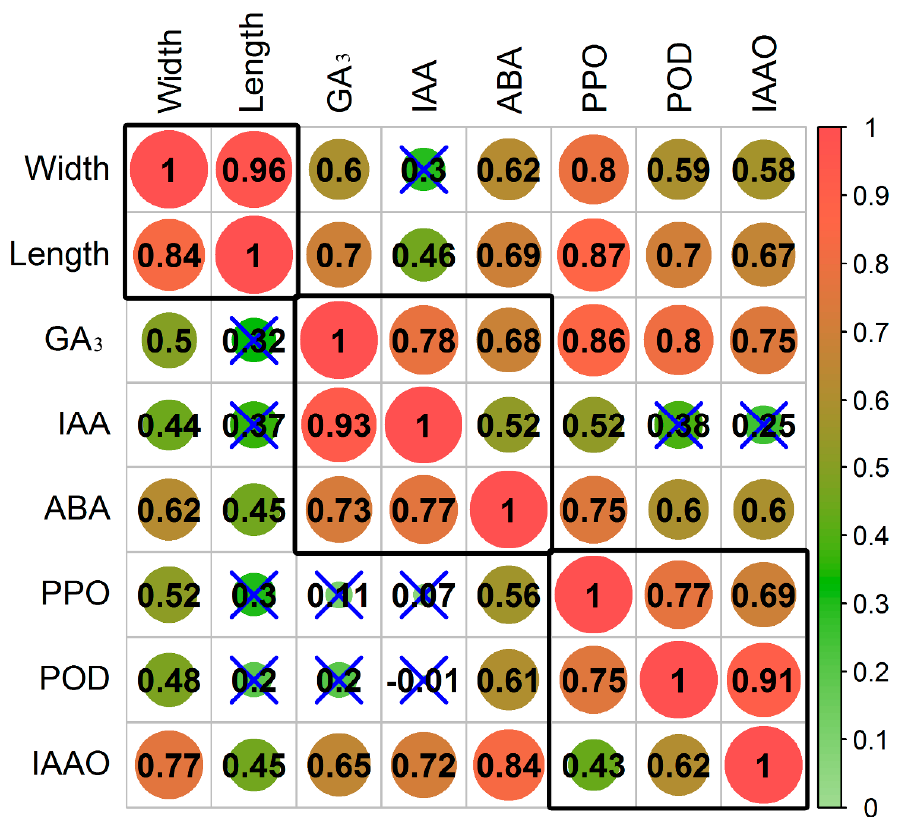
Figure 2. Correlations between growth, hormones, and enzymes. The left diagonal shows the correlations of inverted cuttings, and the right diagonal shows the correlations of upright cuttings. The correlation coefficient without significance is marked with a blue “ × ” symbol.